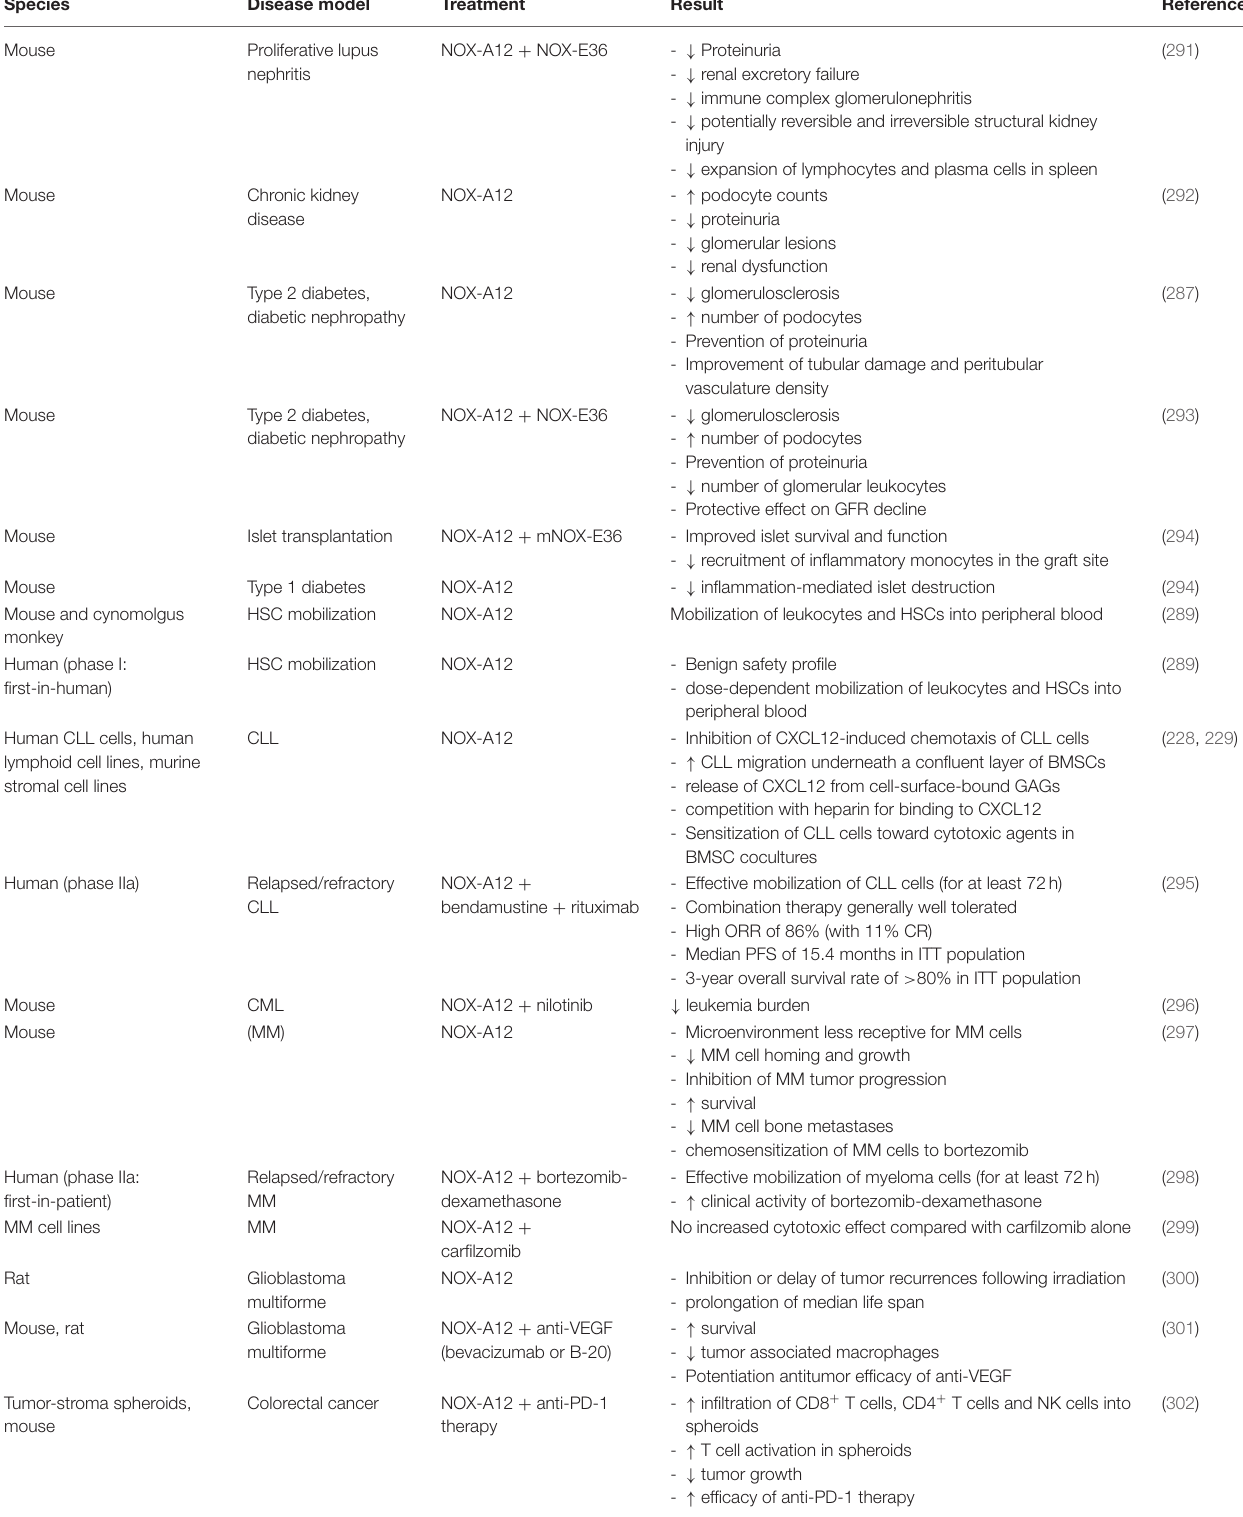
TABLE 2 | Overview of the use of NOX-A12 as a treatment strategy in different preclinical models and clinical trials.